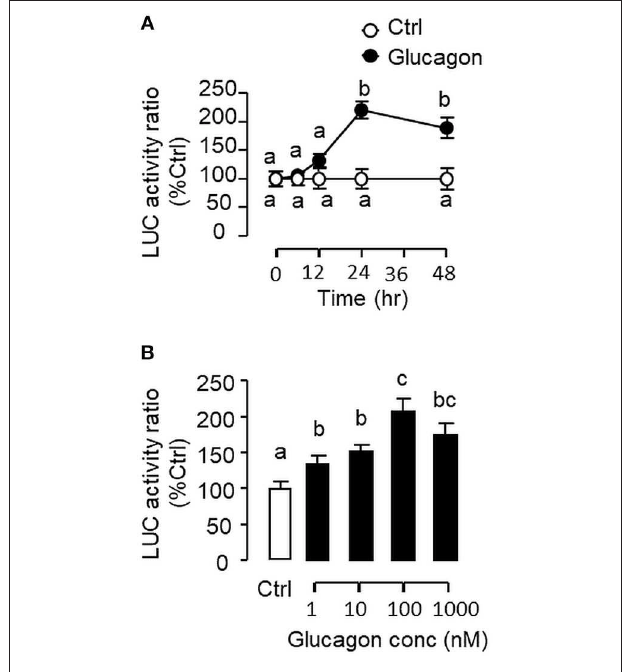
FIGURE 11 | Glucagon-induced IGF-I promoter activity expressed in α T3 cells. (A) Time course and (B) Dose dependence for glucagon induction of IGF-I promoter activity of carp origin. Transfection studies was performed in α T3 cells with pIGF1(-1077).Luc carrying a 1,077 bp 5 ′ promoter of the carp IGF-I gene. Glucagon treatment was initiated after 15h incubation to allow for recovery after transfection. For time course experiment, the dose of glucagon used was fixed at 100nM for the duration as indicated, while the duration of treatment was fixed at 24h for the dose-response study. After glucagon treatment, cell lysate was prepared from α T3 cells and used for luciferase activity